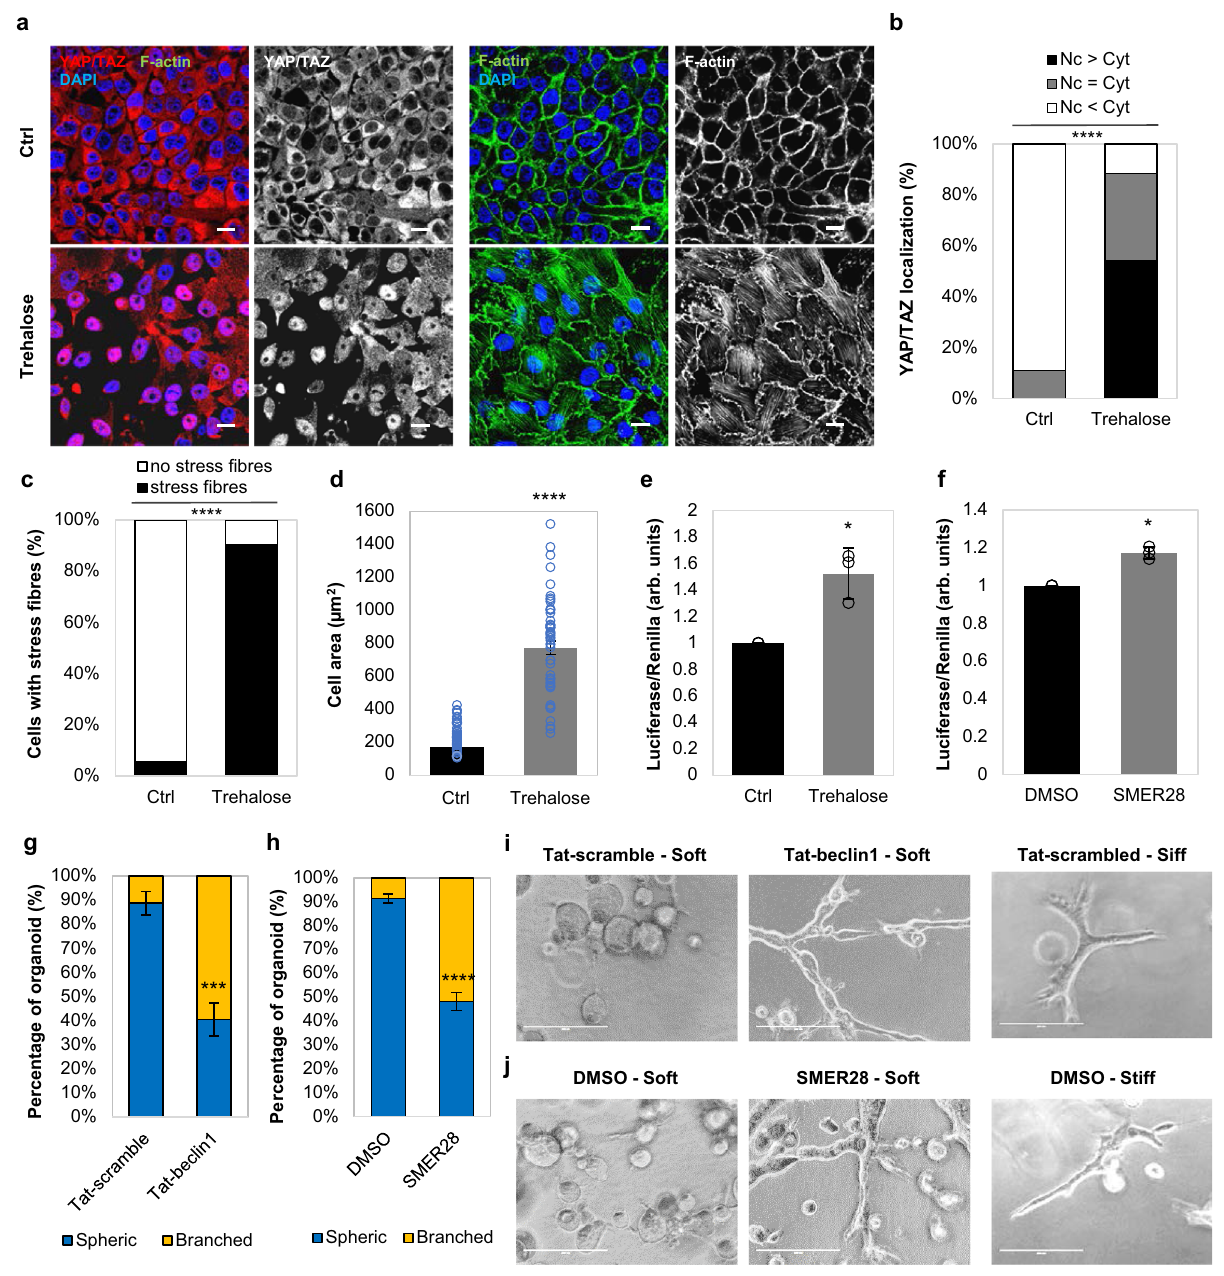
Fig. 4 YAP/TAZ is activated upon autophagy induction (Trehalose, SMER28) in MCF10A cells. a Representative confocal images of YAP/TAZ and F- actin (phalloidin) immunostaining in MCF10A cells cultured at high con fl uency and exposed to trehalose (100 mM for 24 h). Scale bars are 10 µ m. The experiment was repeated at least once with similar results. b YAP/TAZ localisation in MCF10A cells exposed to trehalose (100 mM for 24 h) with at least 100 cells analysed per condition (**** P < 0.0001; chi-squared test). The experiment was repeated with similar results. c Percentage of MCF10A cells with